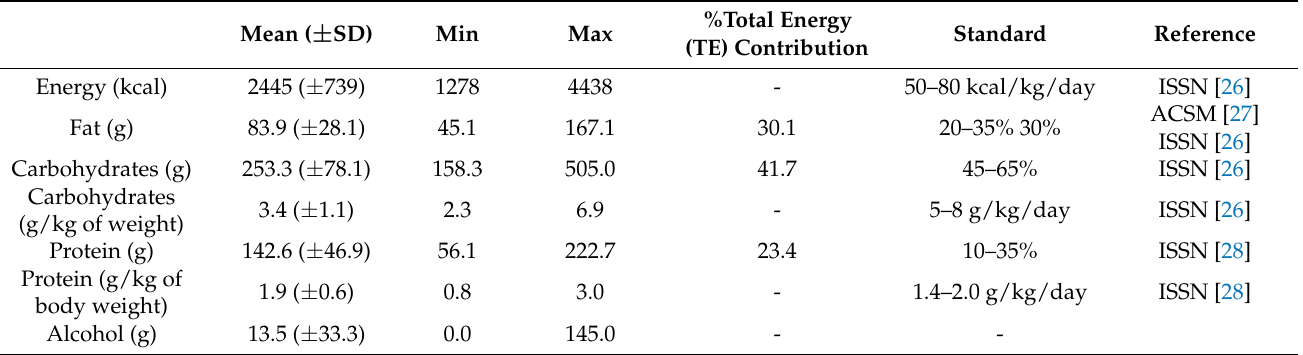
Table 3. Nutritional intake of the players (daily mean from three training days, three resting days and day of the competition event) (n = 20) in terms of compliance with